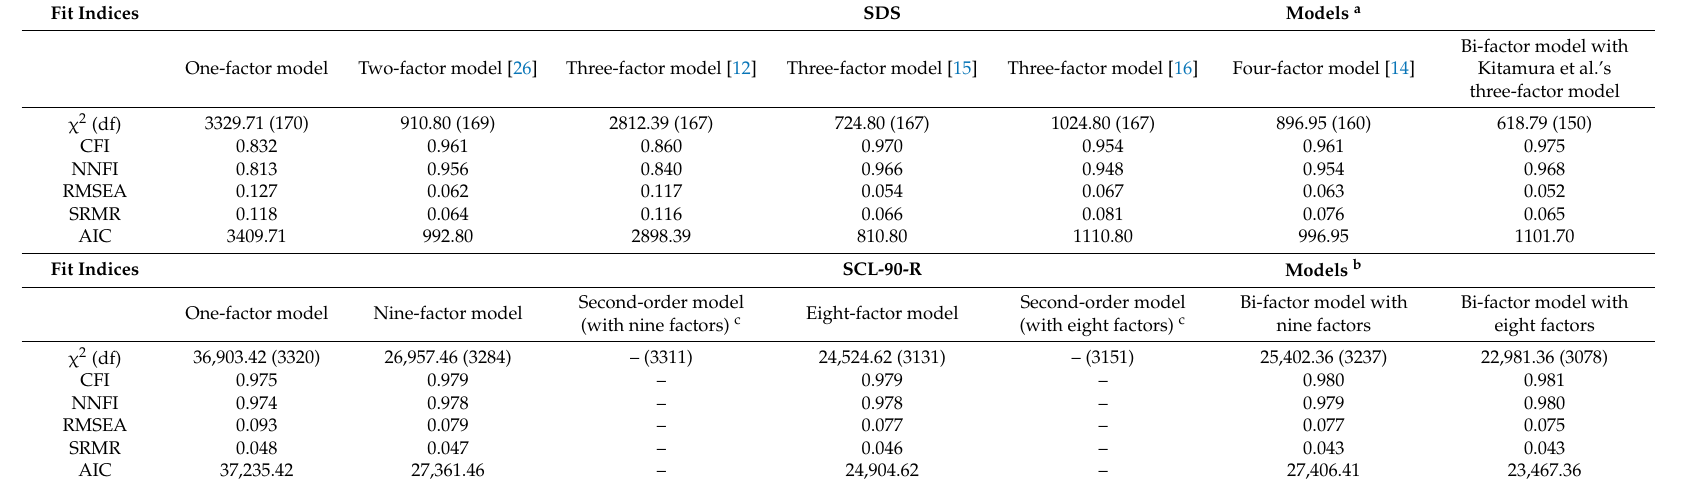
Table 2. Model comparison of SDS and